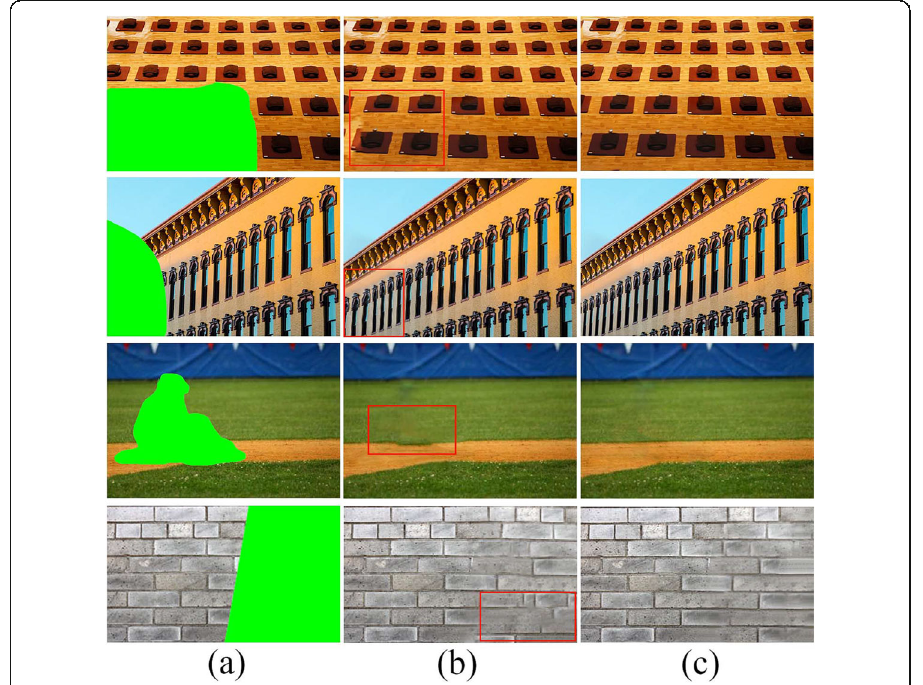
Fig. 9 Comparison with Huang ’ s work. a Input. b Huang ’ s results. c Our